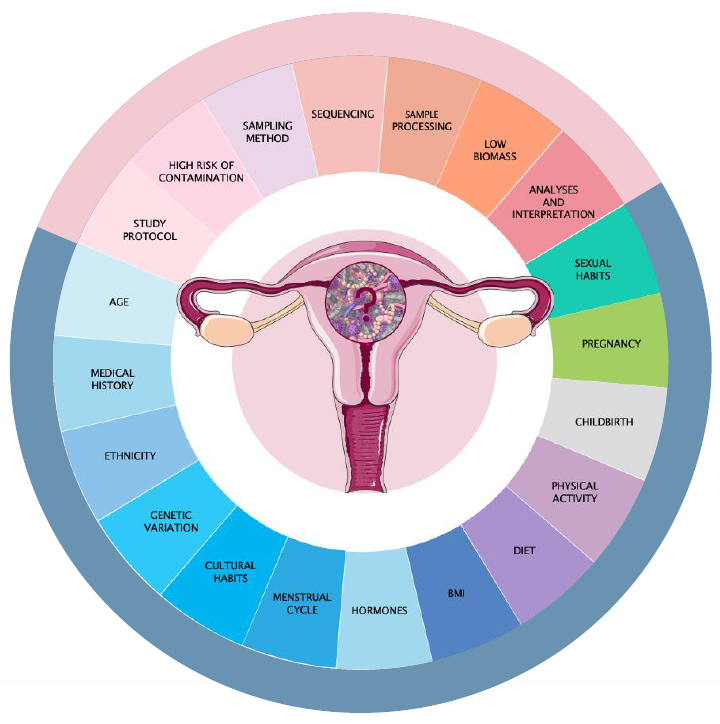
Figure 1. Dynamics and factors that could influence the endometrial microbiome and its analysis, including technical factors in the experimental design and individual/participant/group factors that could fluctuate the microbial composition in the uterus. Age: microbiome changes along lifespan [48], and the diversity and composition decline in the elderly [49,50]. Medical history: genital and extragenital diseases [19,22,23,51], including history of sexually transmitted infections can influence microbiome analysis. Ethnicity and different geographic regions: the ethnic origin of individuals seems to be an important factor to consider in microbiome research [52–55], as African American and Hispanic women show a trend to be more colonised with a non- Lactobacillus species in the upper genital tract than Caucasian women [34]. Genetic variation: host genetics can affect microbiome composition and maintenance [56,57]. Cultural habits: these habits showed leading to microbial variations [58]. Menstrual cycle and hormones: fluctuations in circulating oestrogen and progesterone levels might influence endometrial microbiome [19,57,59,60]. BMI: body mass index, especially obesity has been associated with altered intestinal microbiome composition [61,62]. Diet: it was shown that the gut microbiome not just metabolises ingested food but is itself shaped by the mode and type of food consumption [63,64]. Physical activity: exercising has shown to impact microbial composition [65,66]. Childbirth and pregnancy [67–70]. Sexual habits: the concept of seminovaginal microbiome, i.e., the partners share their microbial communities, has gained support [29]. Spermicidal agents could disrupt endometrial microbiota [71]; also sexual debut and activity can influence genital microbiome [72,73]. Study protocol: different protocols (collection technique, sample storage, extraction method, choice of primers) can lead to different results [74–80]. High risk of contamination: laboratory and reagent contamination can critically impact sequence-based microbiome analyses [81–84]; negative controls consisting of blanks are recommended [81,82,85,86]. Sampling method: an important point to consider consists in avoiding the surface of the vagina and the walls of cervical canal when taking the endometrial sample [87,88]. Sequencing: different sequencing platforms and sequencing filtering and processing can result in different outcomes [46,89,90]. Sample processing: amplicon sequencing has shown to cause great variance [75,90]. Low-biomass: high risk of misinterpretation of the results [26,91,92]. Analyses and interpretation: statistical analyses and interpretation can induce bias [84,90,93].